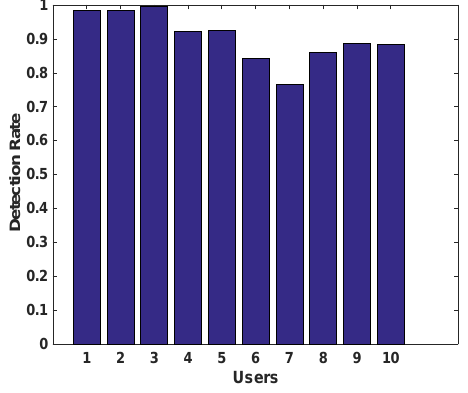
Figure 9. The performance of gesture